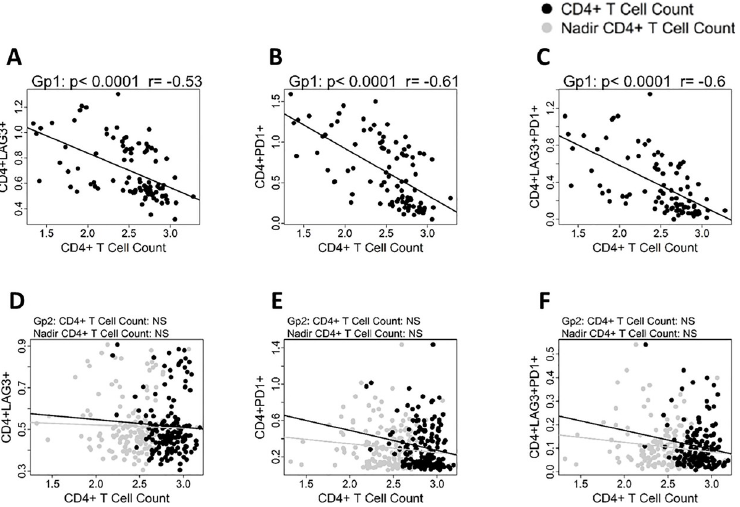
We also measured soluble form of LAG-3 in plasma from a subset of participants from each of the three groups, (S1 Fig) . Levels of sLAG-3 were significantly higher in the ART na ï ve group as compared to virologically suppressed- and healthy control groups, which were not different from each other.